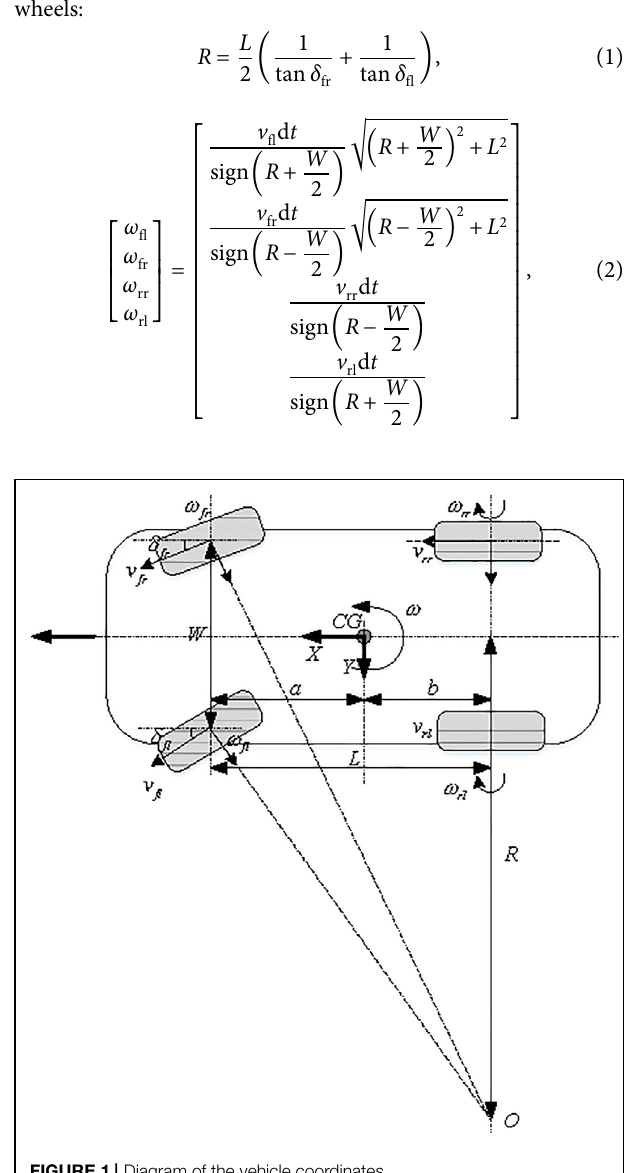
FIGURE 1 | Diagram of the vehicle